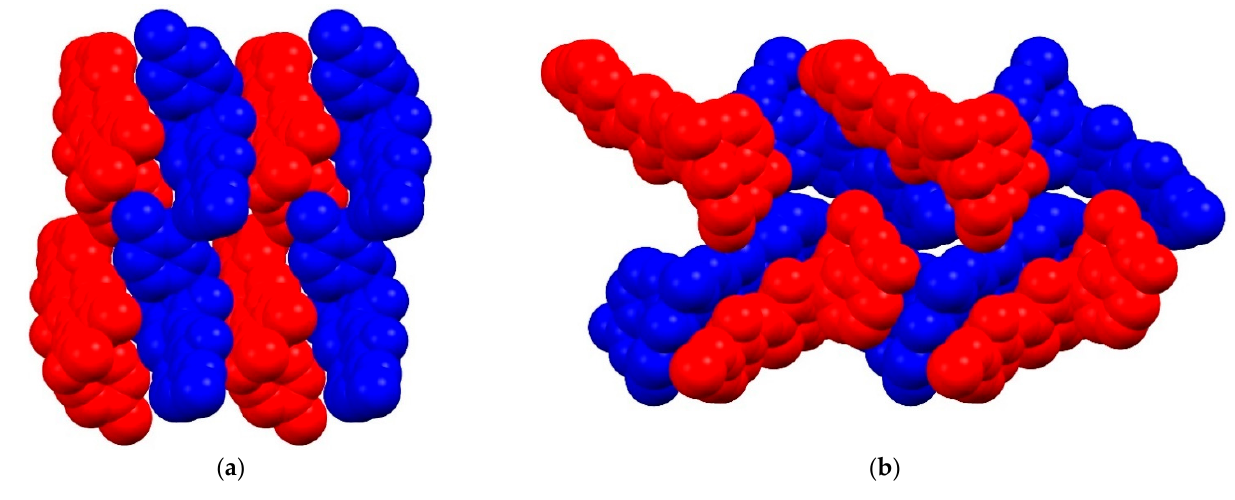
Figure 3. Part of the crystal packing of R– and S–hydrogen-bonded dimeric structures (colored blue and red, respectively) for 1 ( a ) and 2 ( b ).